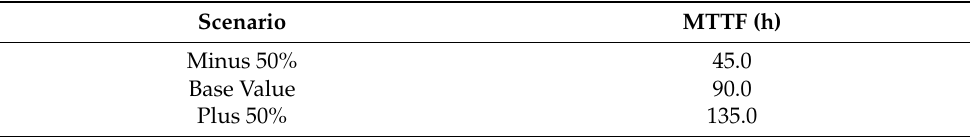
Table 2. Parameters variation of camera’s mean time to failure